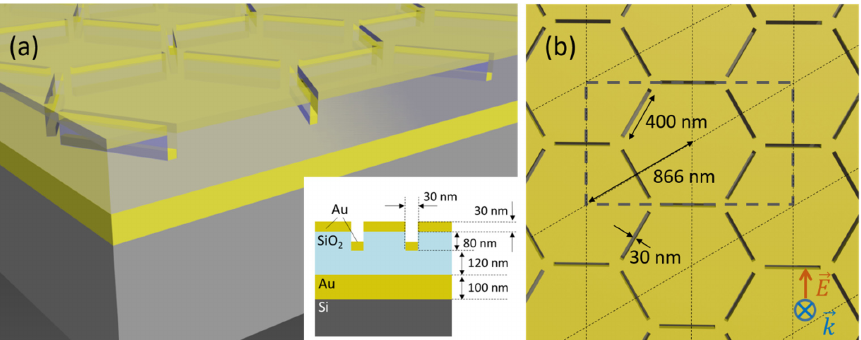
Figure 1. ( a ) Scheme of the heterostructure. The inset shows a schematic cross-sectional view. ( b ) Top view showing the honeycomb lattice, the hexagonal Bravais lattice (dotted lines), a rectangular unit cell (dashed grey lines), and some relevant parameters of the design. Regular rhombus are primitive cells of the hexagonal lattice. The cell for the simulations is the rectangular unit cell. At the bottom left corner of the panel, there is a schematic representation of the electric field and propagation vectors of the incident radiation.